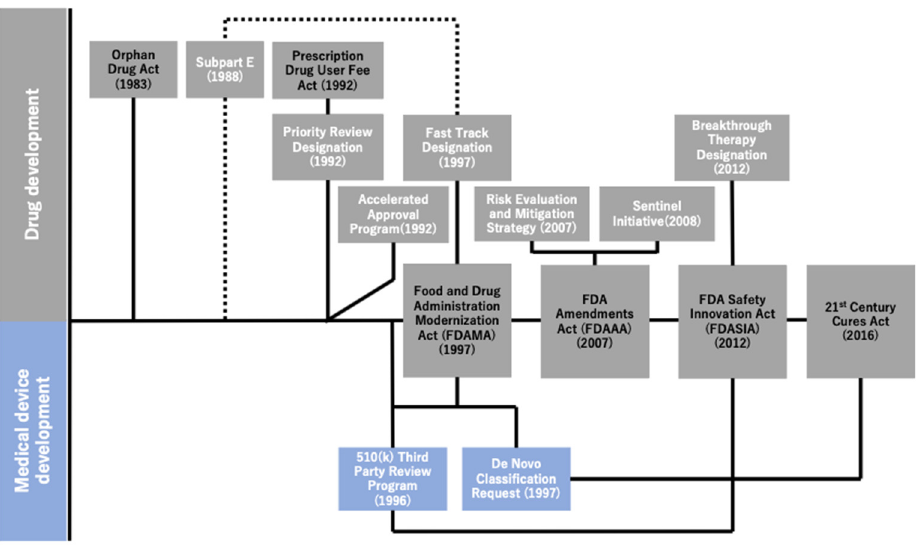
Figure 2. Historical overview of regulatory reforms by the U.S. Food and Drug Administration (FDA). This figure illustrates the association between the four major acts and relevant regulatory programs, actions, etc. in chronological order. The four major acts are lined up on the center line and are tied up with essential regulatory programs and actions implemented under any of such acts (i.e., the FDASIA and the Breakthrough Therapy Designation). The association between the subpart E regulations and the Fast Track Designation is expressed using the dotted lines because the former is the predecessor of the latter.